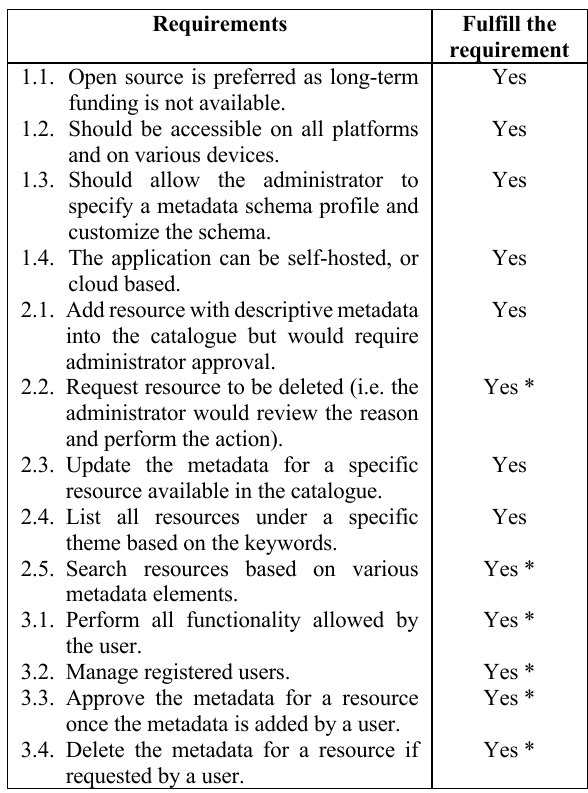
Table 2. Overview of fulfilment of the requirements of the custom catalogue